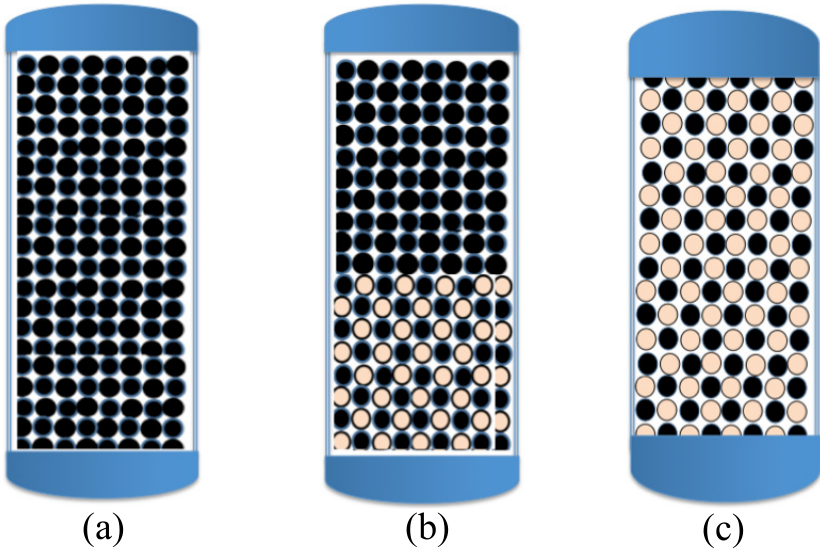
Figure 2. Schematic diagrams of the common design of individual Fe 0 -based filters: ( a ) pure Fe 0 (100%); ( b ) a pre-treatment hybrid zone (e.g., Fe 0 /sand) followed by